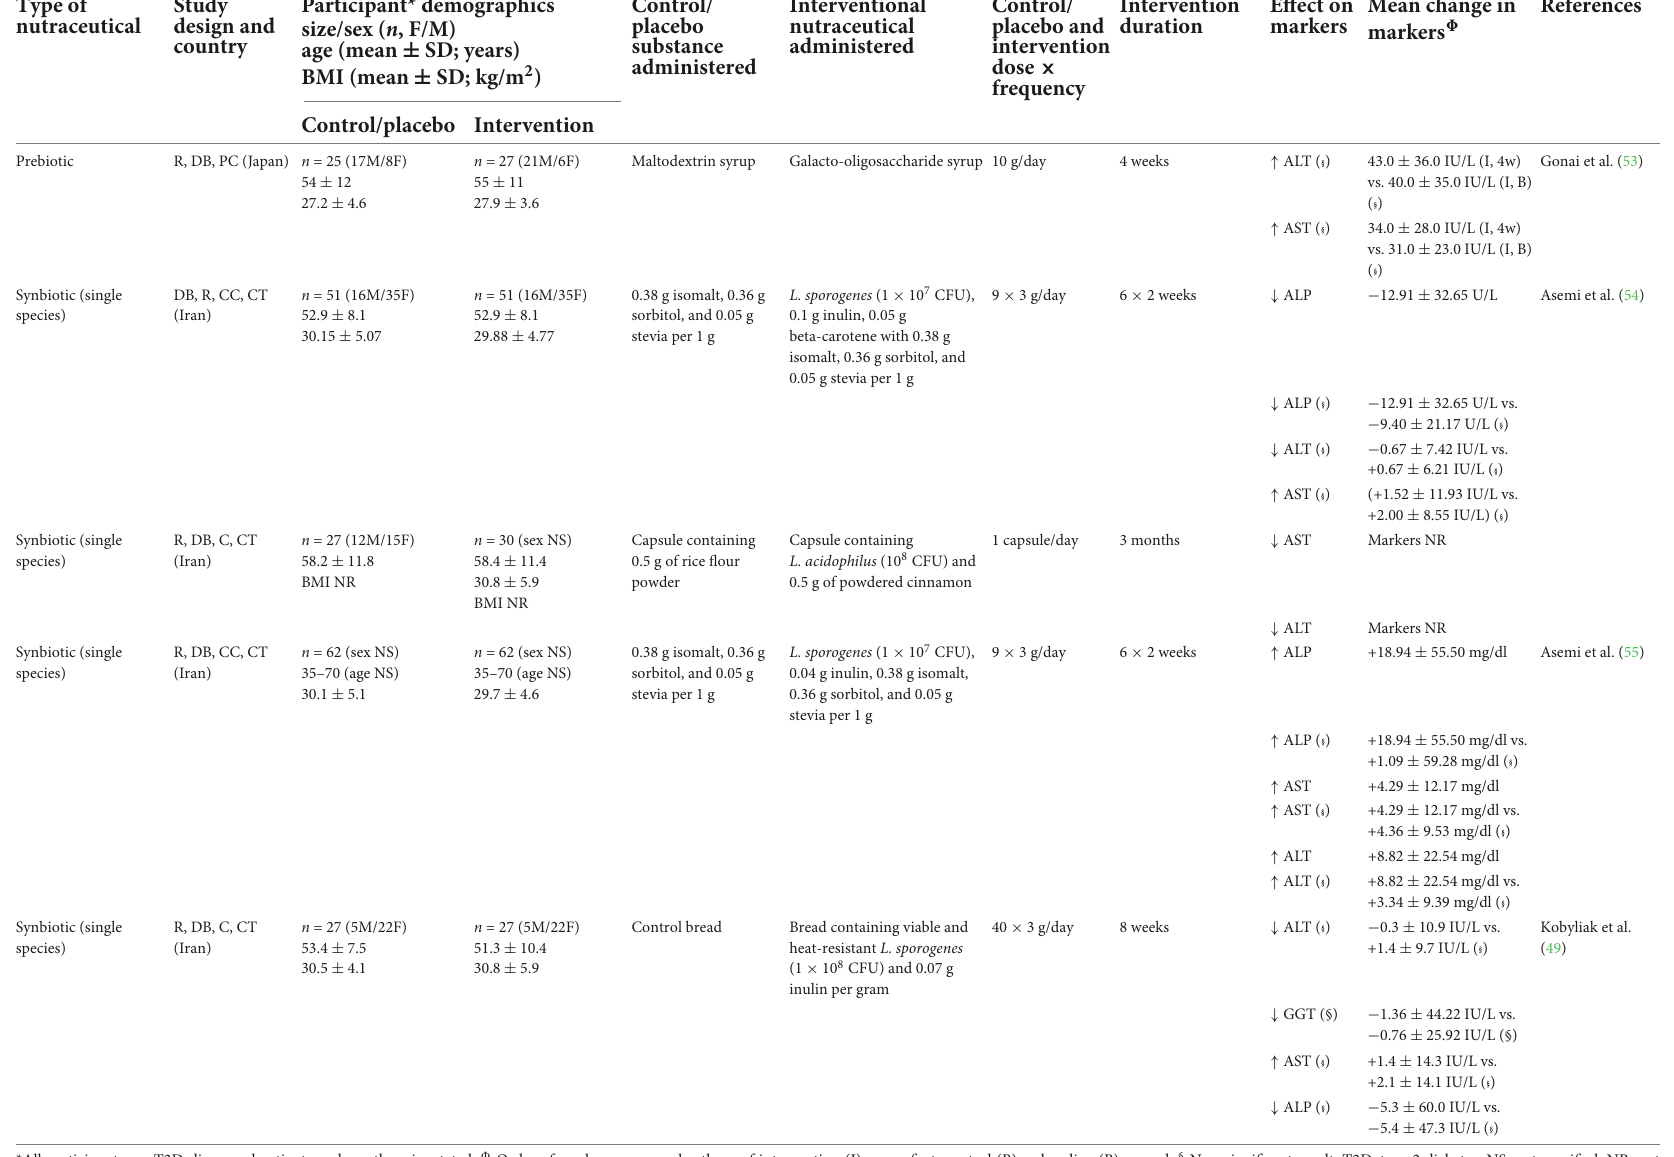
*All participants are T2D-diagnosed patients, unless otherwise stated. (cid:56) Order of markers compared = those of intervention (I) group first, control (B) or baseline (B) second. § Non-significant result. T2D, type 2 diabetes; NS, not specified; NR, not reported; Sp., species; SB, single-blinded; DB, double-blinded; TB, triple-blinded; R, randomized; RCT, randomized controlled trial; CC, crossover controlled; PC, placebo-controlled; PG, parallel group; CT, clinical trial; UCS, uncontrolled study; ALP, alkalinephosphatase;ALT,alanineaminotransferase;AST,aspartateaminotransferase;LS,liverstiffness;FLI,fattyliverindex;LDH,lactatedehydrogenase; γ